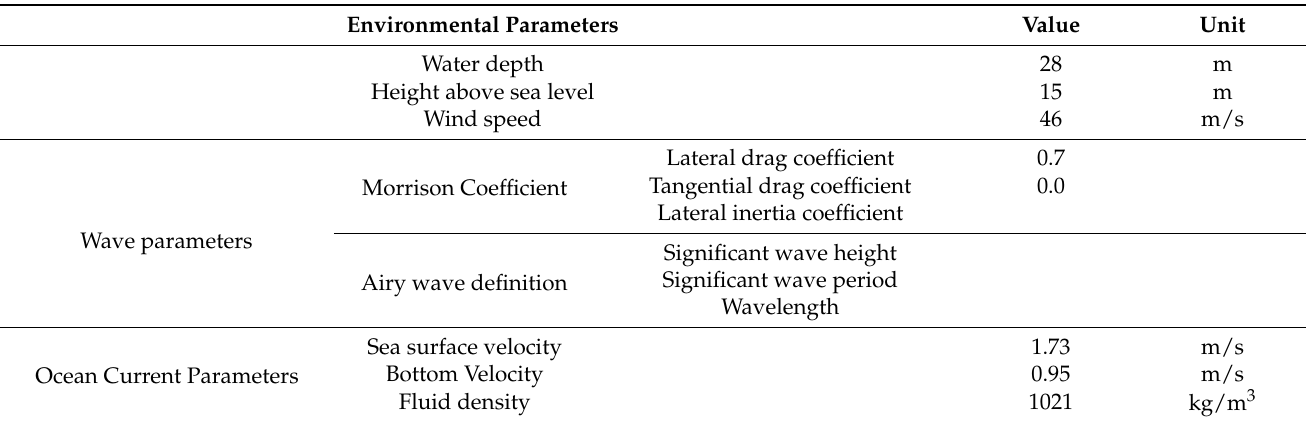
Table 3. Environmental parameters.